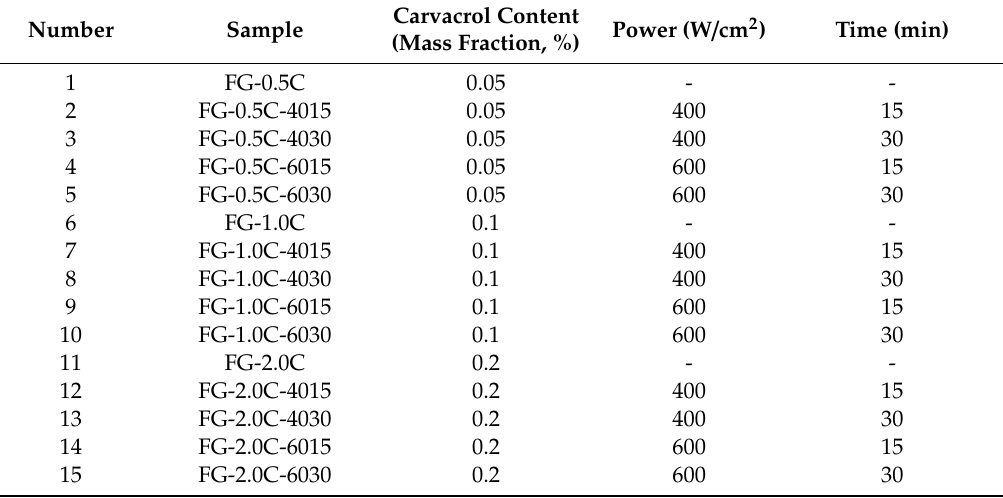
Table 1. Sample preparation with di ff erent sonication powers and